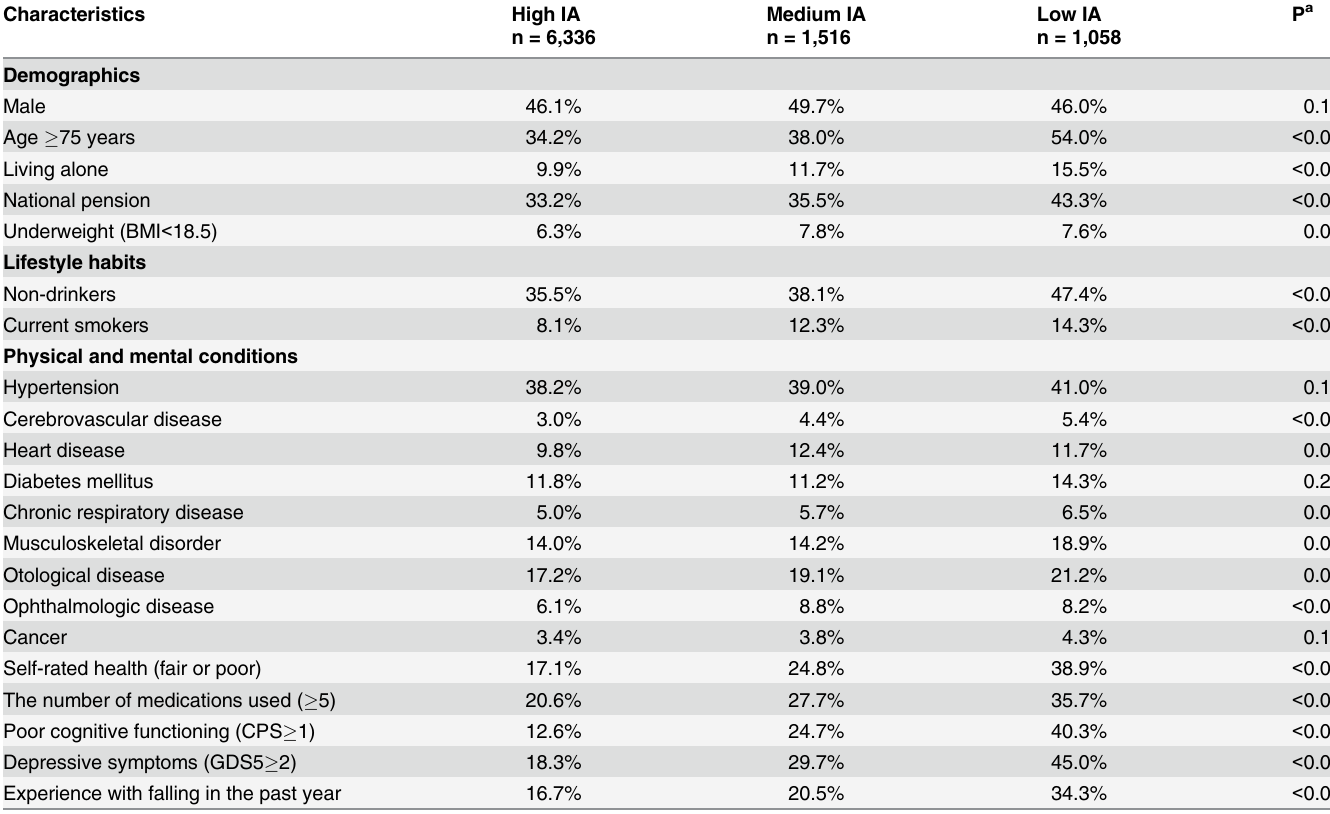
Table 2. Demographics, Lifestyle Habits, and Physical and Mental Status of Participants Stratified by the Level of Intellectual Activity.